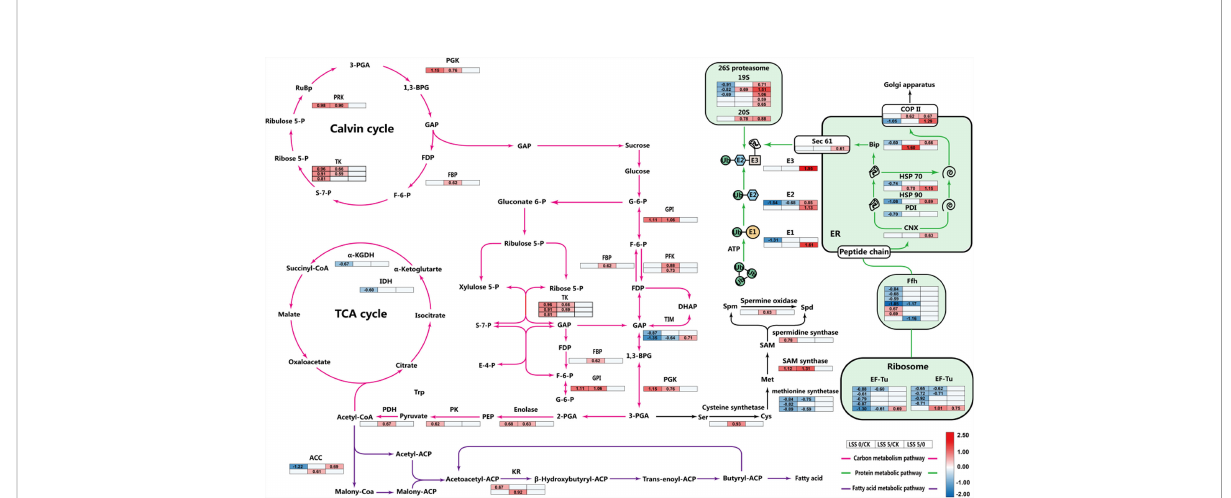
FIGURE 2 Response metabolism map of P. haitanensis under hyposaline stress. Red lines represent the carbon metabolism pathway, green lines represent the protein synthesis and processing pathway, and purple lines represent fatty acid metabolism. Values in the tables are changes in content of selected proteins; the left, middle and right columns give values for LSS 0 vs. control, LSS 5 vs. control, and LSS 5 vs. LSS 0 treatments, respectively. The colors re fl ect the protein content differences relative to the protein ’ s abundance under control conditions: red, blue, and white correspond to increased, decreased, and unchanged protein contents, respectively. Numbers represent log 2 fold change (FC) values for FC ≥ 1.5 and P < 0.05, which are considered signi fi